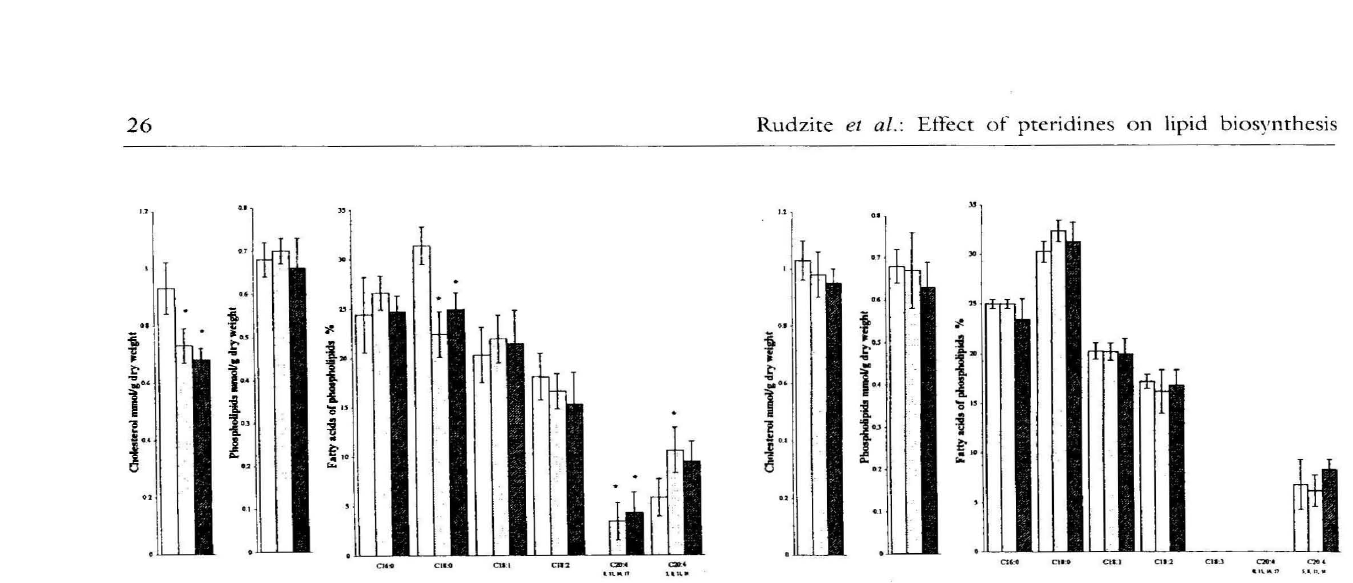
Figure 3. Concentrations (mean ± S.D.) of chqlesterol and phospholipids, as well as fatty acid content (in per cent: mean ± S.D.) of phospholipids in controls (open bars) and in samples with 5 pmol/g wet weight (dotted bars) or with 30 pmoljg wet weight (hatched bars) isox anthopterin. Samples of rat liver tissue homogenates were used to test for phospholipid biosynthesis in